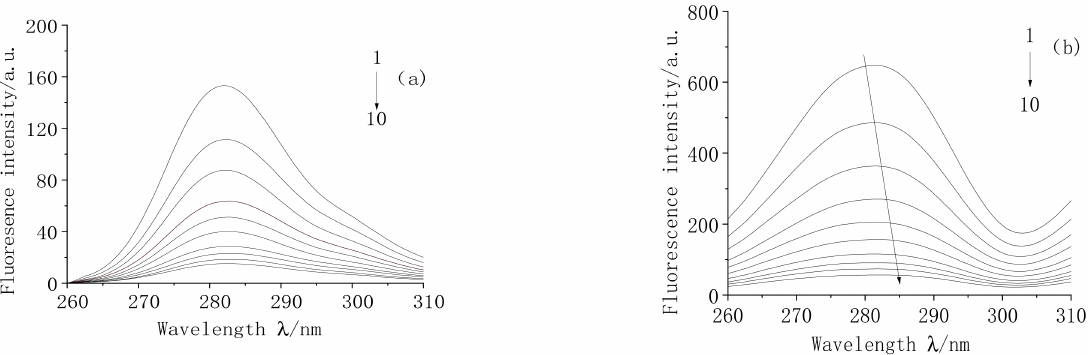
Figure 6. Synchronous fluorescence spectra of MC and TRP. ( a ): ∆ λ = 15, ( b ): ∆ λ = 60; T = 298 K; pH = 7.4; C (TRP) = 3 × 10 − 5 mol/L; C (MC) (1–10) 0, 0.5, 1, 1.5, 2, 2.5, 3, 3.5, 4, 4.5 × 10 − 4 mol/L.